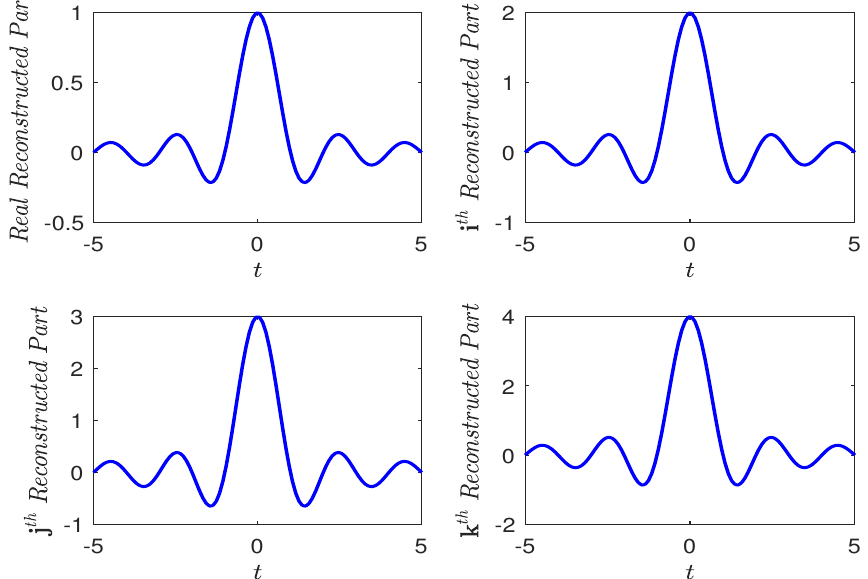
Figure 4. The reconstructed quaternionic